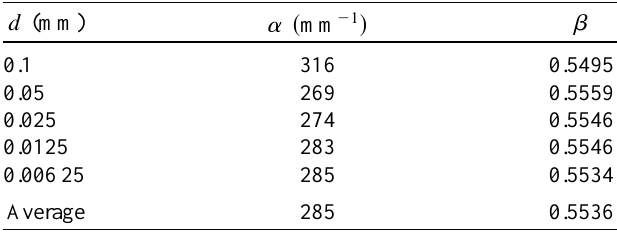
TABLE II. Fitting constants a and b [see Eq. (6)] for random multipoles generated by random block displacements for the four-block coil of the main LHC